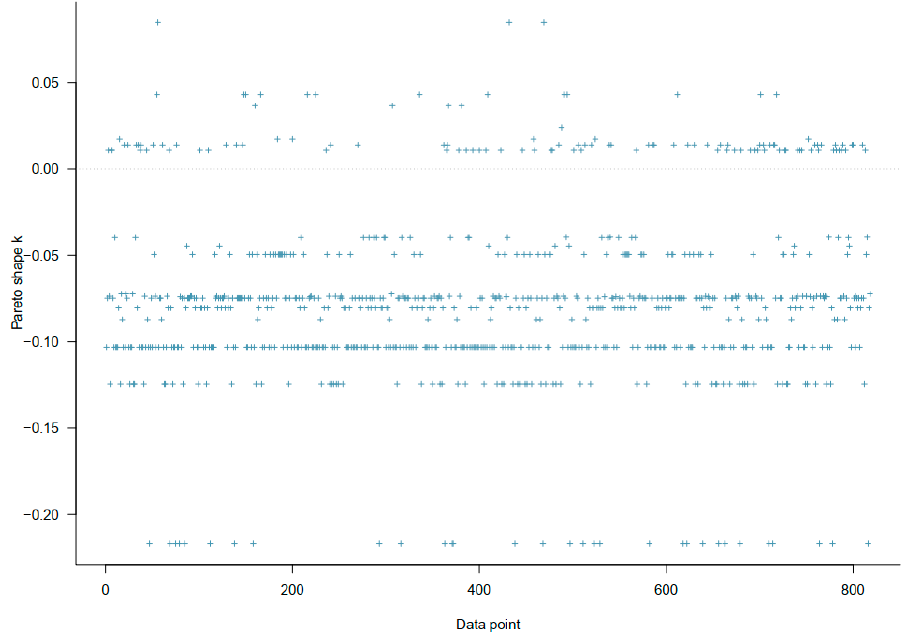
Figure 4. Model 2 ′ s PSIS diagnostic plot. Figure 4. Model 2’s PSIS diagnostic